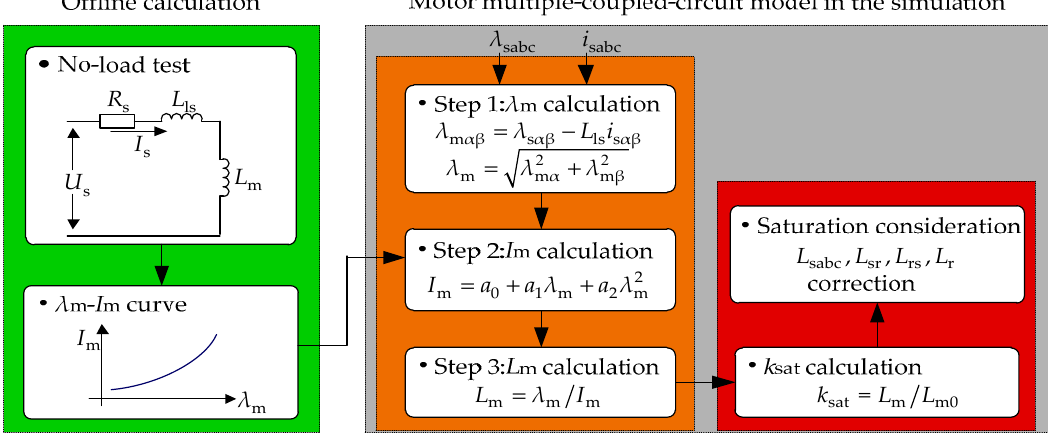
Figure 17. Procedure for inductances correction considering the saturation effect.